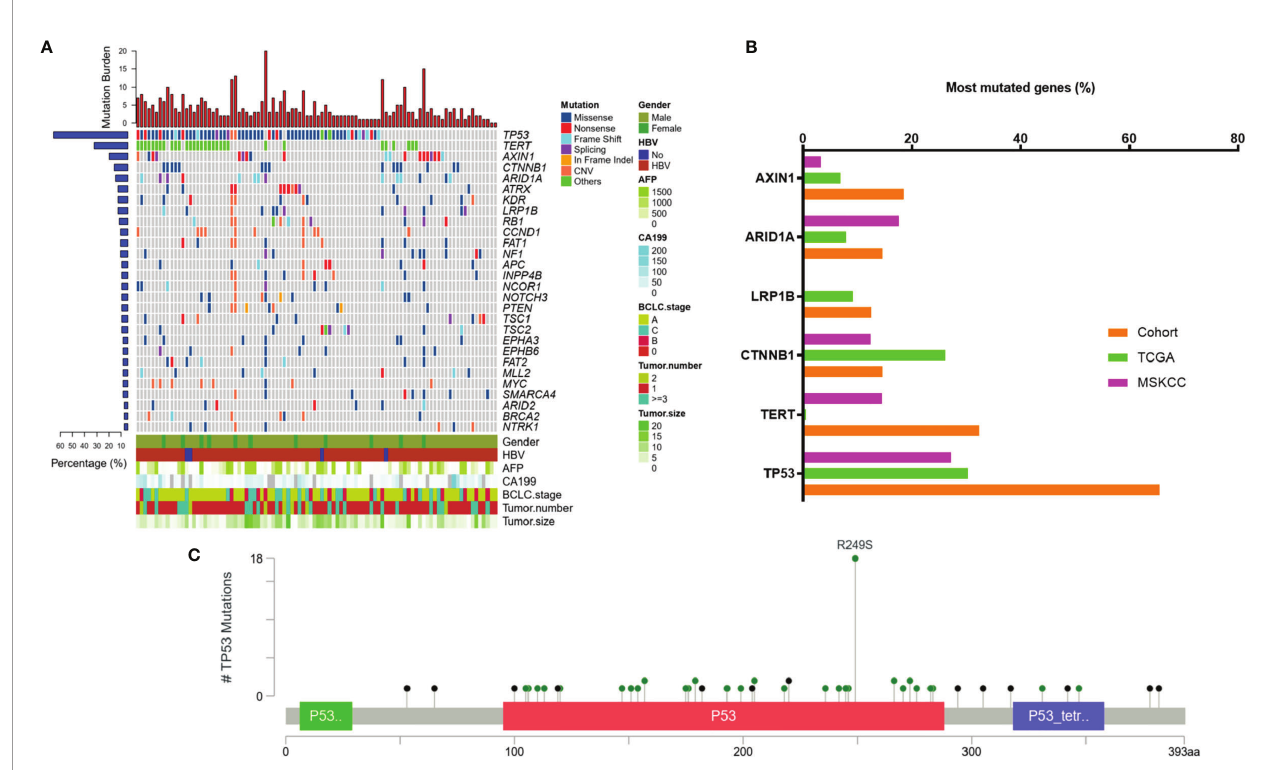
FIGURE 1 | Mutation characteristics of tumor tissue samples. (A) Mutation pro fi les of tissue samples of 96 enrolled patients. (B) Frequently mutated genes in this cohort and the incidence of mutations in these genes in our cohort compared to that in public databases. (C) Lollipop diagram showing mutations in TP53 . TCGA, The Cancer Genome Atlas; MSKCC, Memorial Sloan Kettering Cancer Center; AFP, alpha-fetoprotein; MVI, microvascular invasion; BCLC, Barcelona Clinic Liver Cancer; CA 19-9, carbohydrate antigen 19-9; HBV, hepatitis B